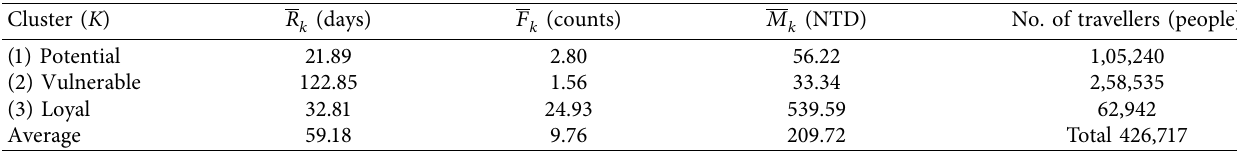
Table 7: Clustering results by K -means for 2019.